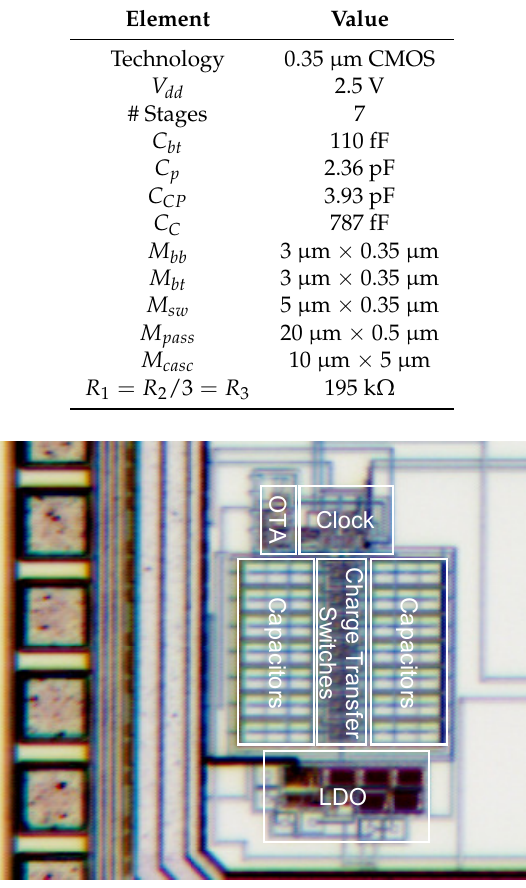
Figure 8. Die photo of the proposed charge